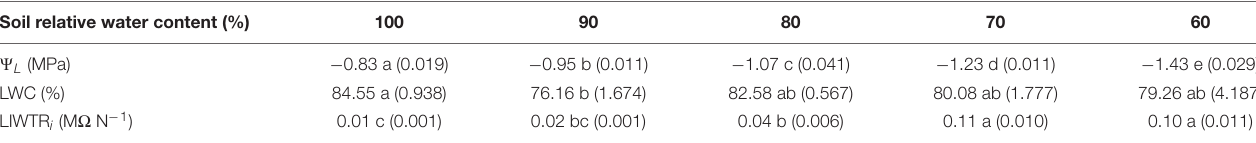
TABLE 1 | Leaf water potential ( (cid:57) L , MPa), water content (LWC, %), and inherent leaf intracellular water transport rate (LIWTR i , M (cid:127) N − 1 ) of Solanum lycopersicum under different water supplies. Soil relative water content (%)